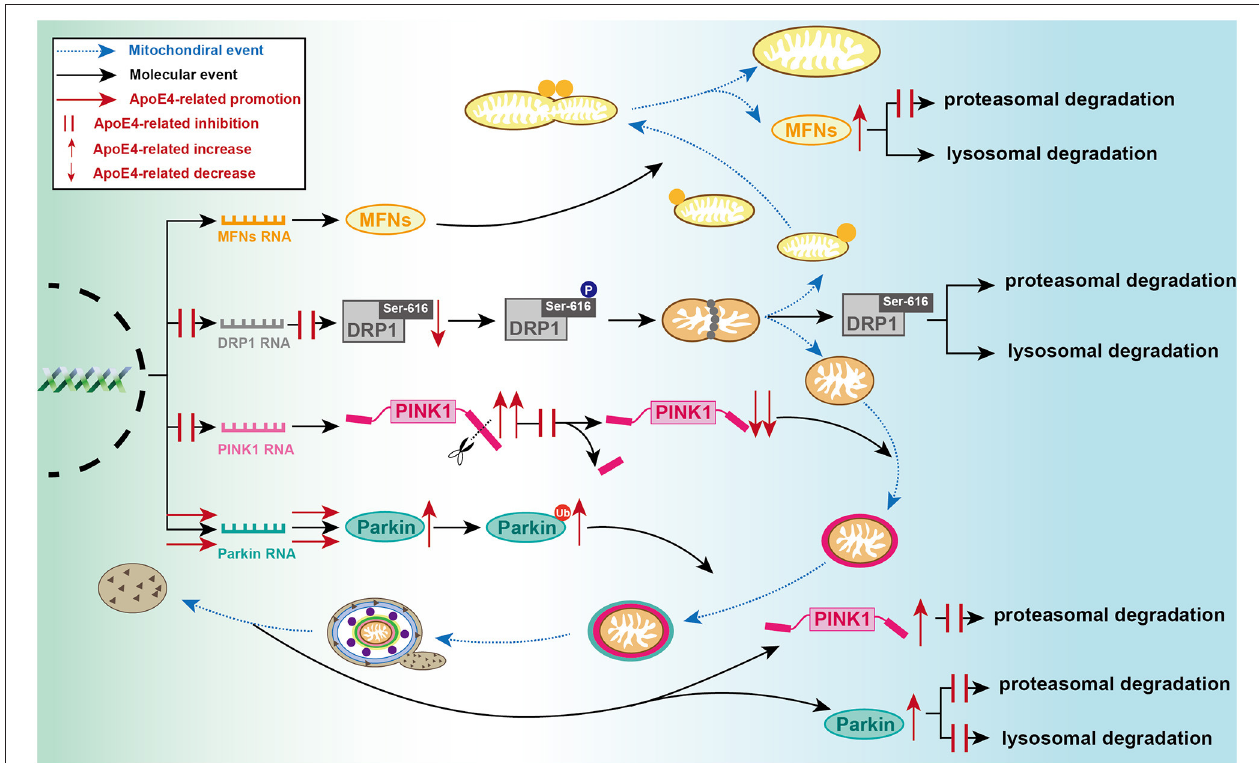
FIGURE 2 | Detailed processes of established ApoE4-mediated regulation of mitochondrial events at molecular level. During mitochondrial fusion, ApoE4 interferes with MFNs proteasomal degradation, then leading to MFN dynamic dysfunction. During mitochondrial fission, ApoE4 inhibits DRP1 transcription and expression, thus leading to a lower capacity of fission. During mitophagic induction, AcpoE4 inhibits PINK1 transcription and impairs proteolytic cleavage of FL-PINK1, exemplified by FL-PINK1 elevation and cleaved-PINK1 reduction. ApoE4 also blocks PINK1 proteasomal degradation, resulting in PINK1 dynamic dysfunction. ApoE4 not only promotes Parkin transcription and expression but also disrupts both proteasomal and lysosomal degradation, leading to a remarkable increase of ubiquitinated Parkin and total